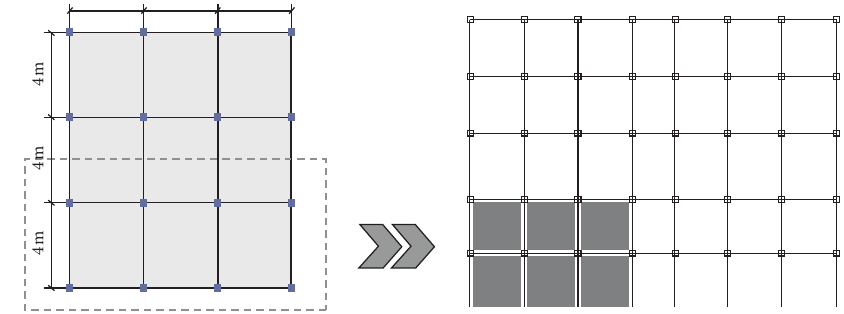
Figure 2: Plan view of archetypes and schematic nonlinear model of them.